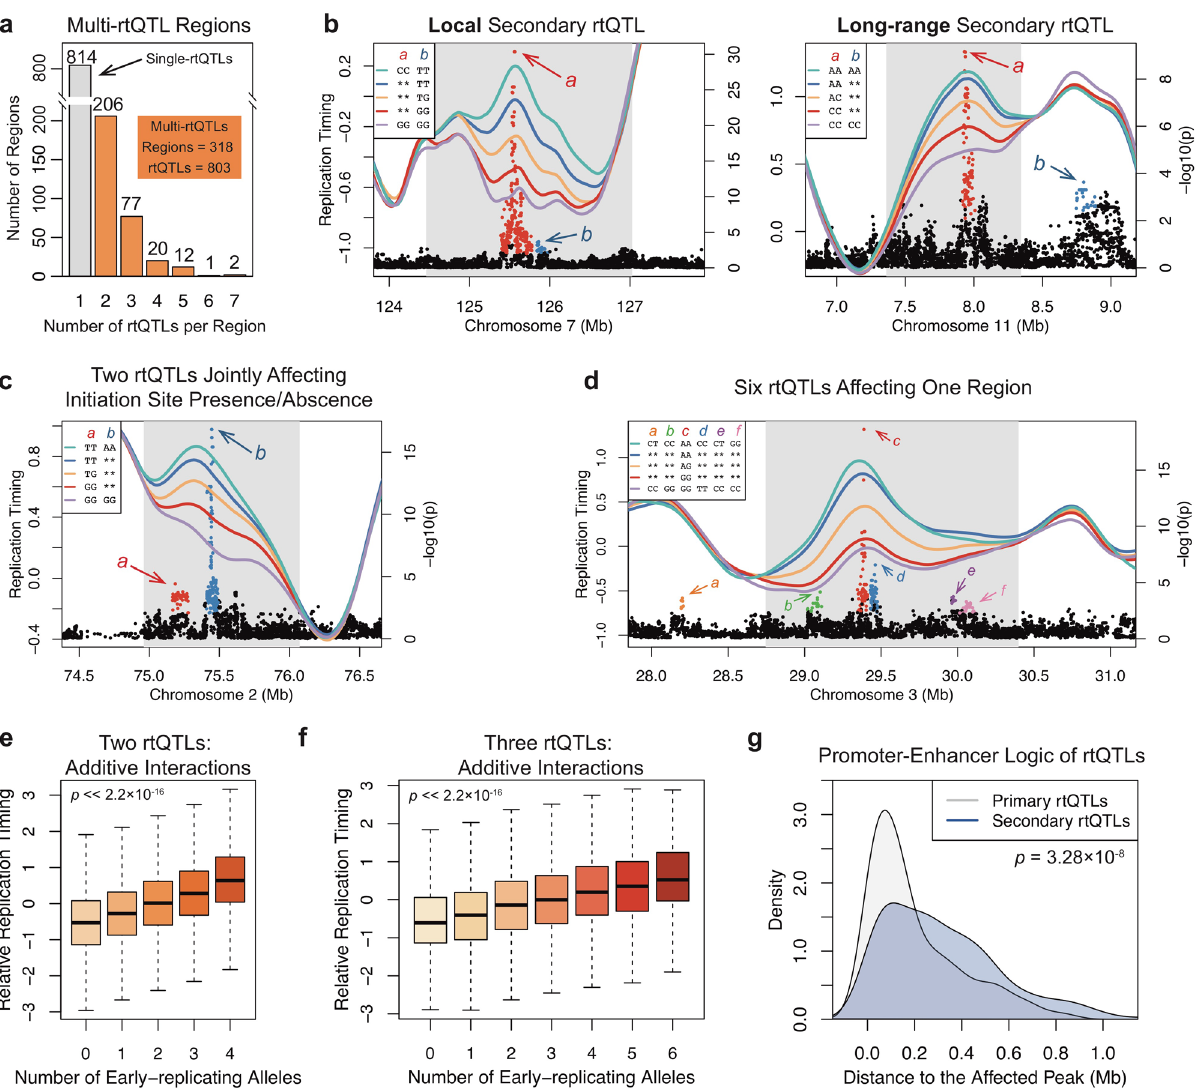
Fig. 2 Multiple DNA Sequences Interact to Regulate Replication Timing. a Hundreds of regions are controlled by multi-rtQTLs. b , c Two rtQTLs affecting the same region. Blue, yellow, and red lines represent one rtQTL. Purple and green lines represent the mean replication timing of individuals carrying the late- or early-replicating genotypes, respectively, at both rtQTLs. Considering both rtQTLs explains a larger fraction of variation (green lines are higher than blue lines; conversely for purple/red lines). Asterisks (in legends): any genotype at this rtQTL. In panel c, the GG/GG combination of alleles is associated with complete loss of initiation activity. d A replication initiation site associated with six rtQTLs. Each rtQTL was signi fi cant even after conditioning on all other fi ve rtQTLs in the region. e , f rtQTLs exert additive effects. All regions with two ( e ) or three ( f ) rtQTLs were pooled; replication timing is linearly correlated to the number of early-replicating alleles ( p values based on linear regression). e : n = 5416, 15,820, 23,551, 16,181, and 7158 genotype-replication timing pairs (for 0 – 4 early-replicating alleles, respectively). f: n = 770, 2136, 3844, 4310, 3520, 2039, and 661 genotype-replicating timing pairs (for 0 – 6 early-replicating alleles, respectively). For panels e and f , the top and bottom whiskers denote the maximum and minimum value, respectively. The top and bottom boxes denote the third and fi rst quartile, respectively. The center denotes the median. Outliers were determined and removed using R boxplot option “ outline = F ” . g Multi-rtQTLs conform to a “ promoter-enhancer ” logic, primary rtQTLs being closer to the affected replication timing peak than secondary rtQTLs (two-sided Wilcoxon rank-sum test p-value